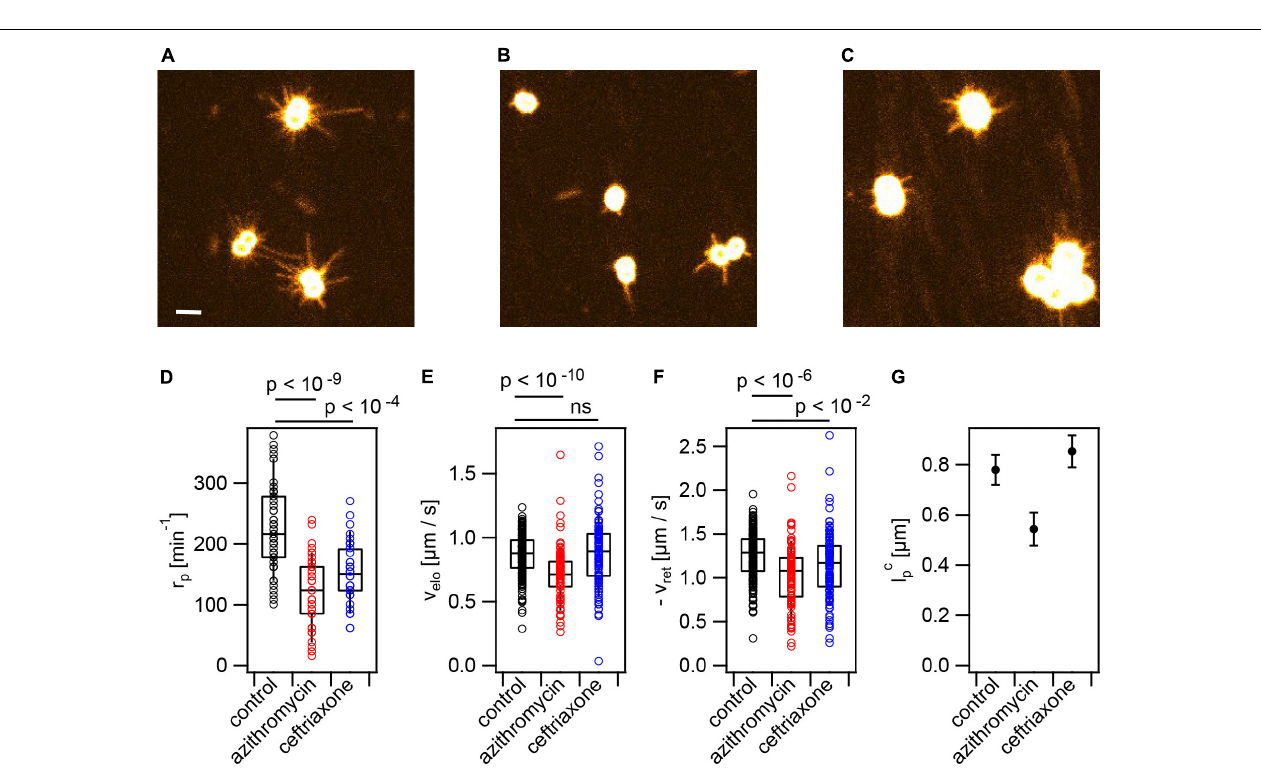
FIGURE 2 | T4P dynamics. (A) Time series of T4P dynamics. The orange box denotes the ROI used for analysis of one pilus. (B) For analysis, each pilus is aligned. Shown is a T4P that elongates and subsequently retracts. Time interval between two images: 0.1 s. (C) Kymograph of T4P shown in panel (B) as used for analysis of T4P elongation and retraction speed. (D) Velocities of T4P elongation, v elo , and retraction, v ret . Shown are circles: single T4P data, box: 25/75 percentiles, and median for 171 T4P.